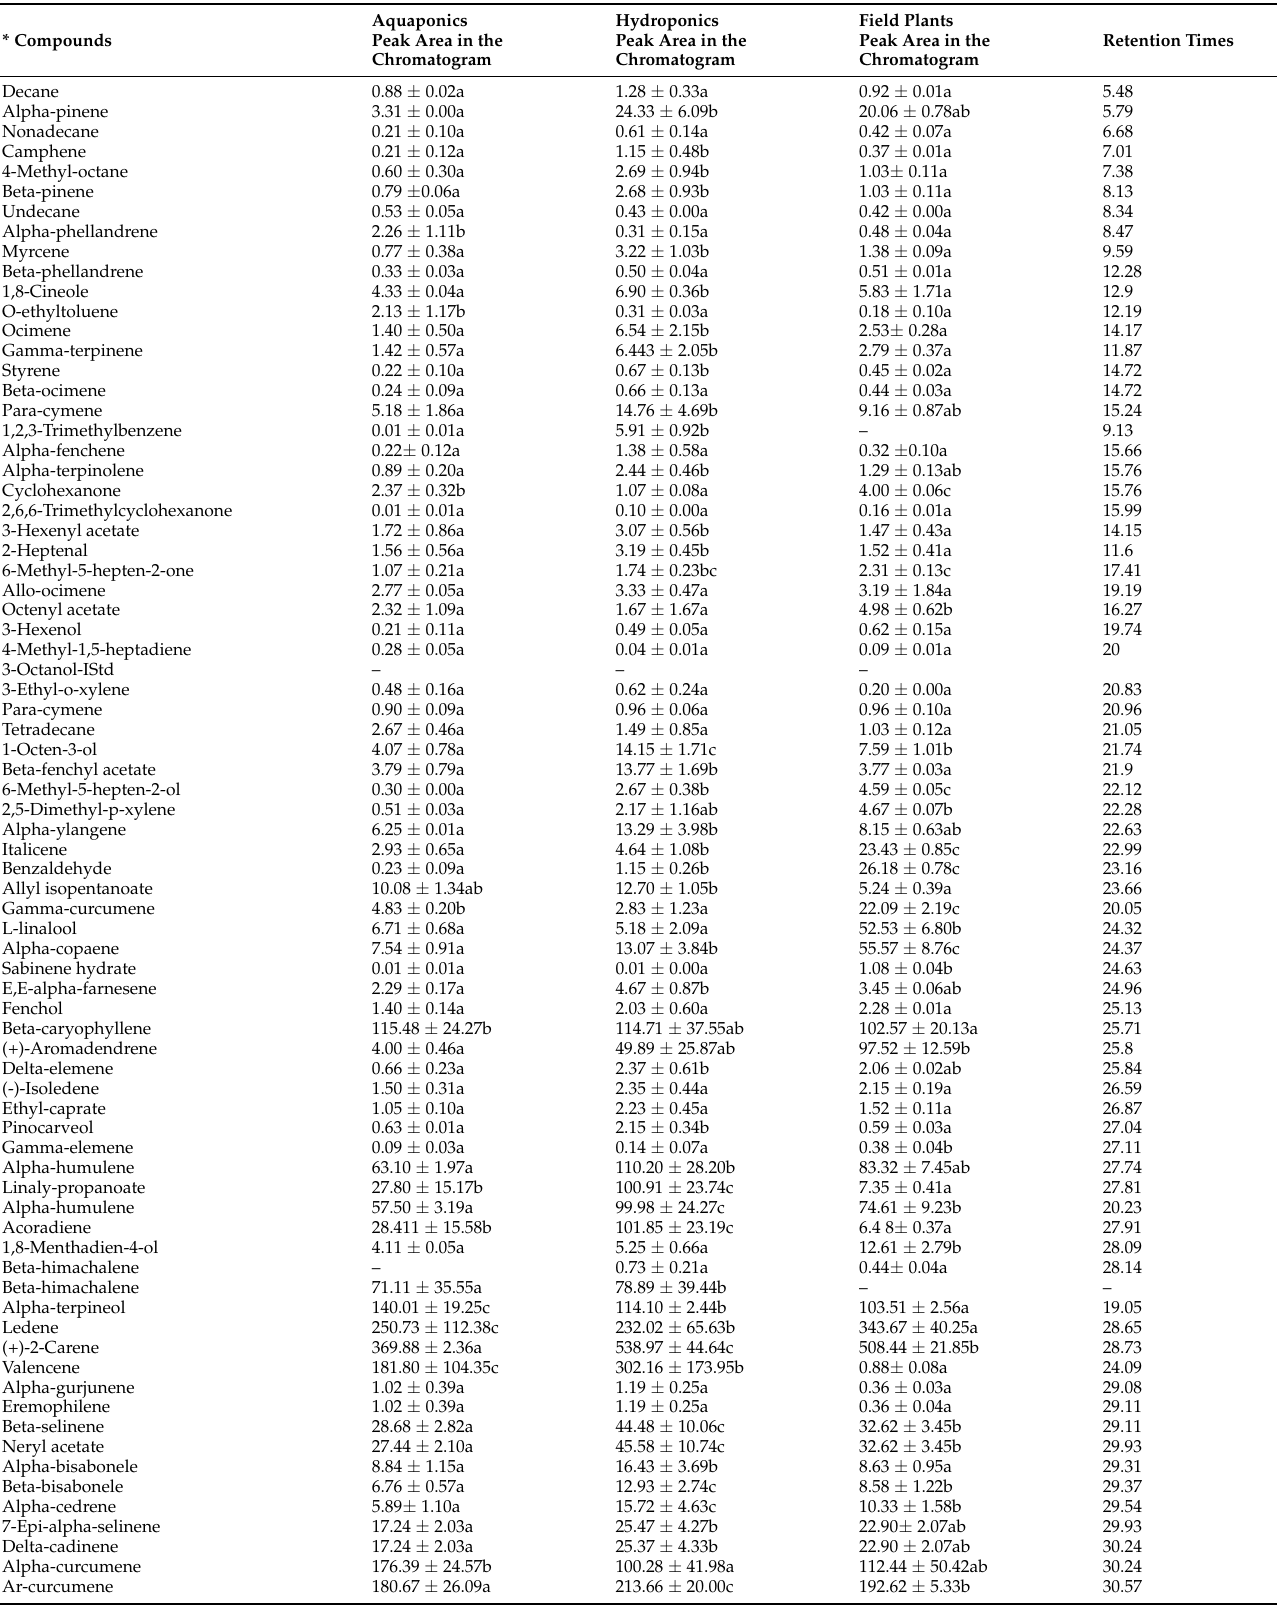
Table 6. Volatile compounds in H. odoratissimum plants grown in aquaponic, hydroponic, and field